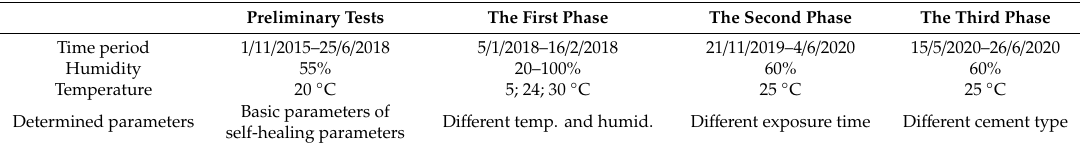
Table 2. Testing program.